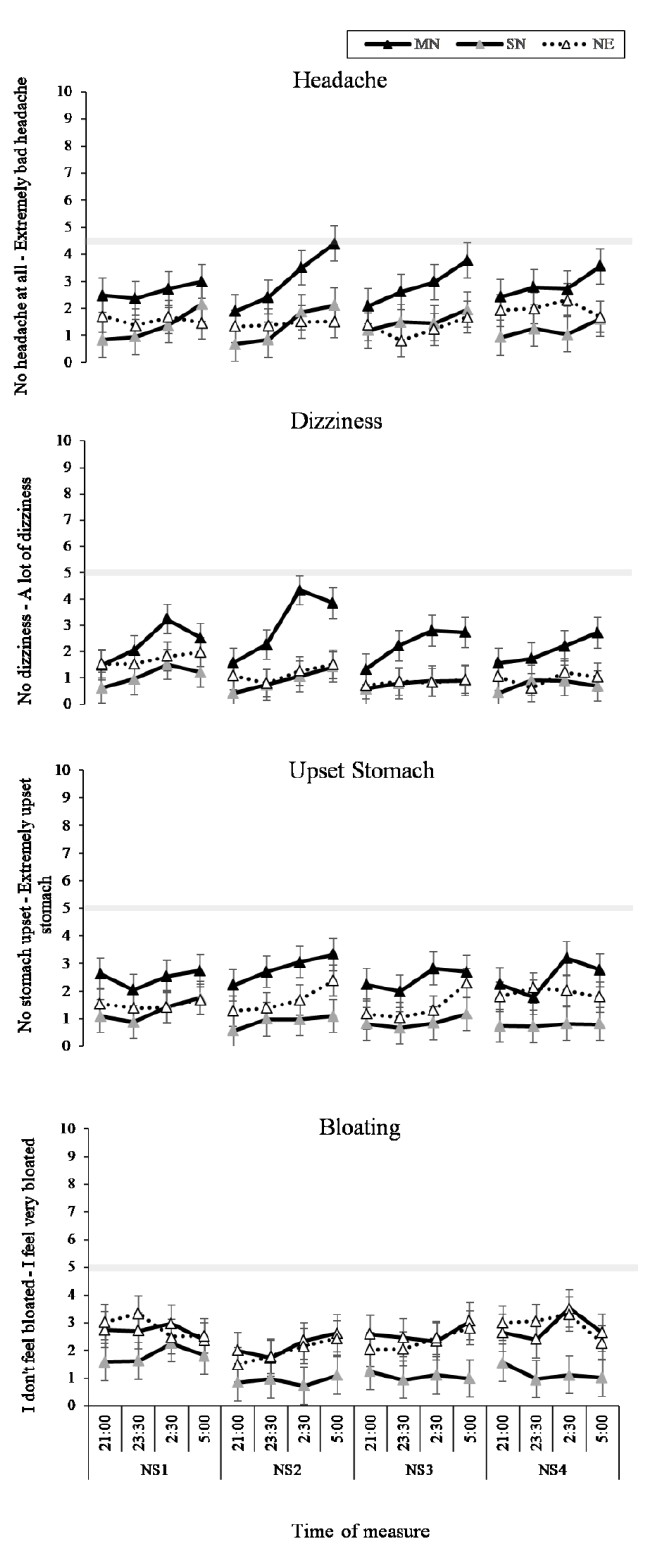
Figure 7. Headache and Gastrointestinal Symptoms (GI) VAS results from the interaction e ff ect between eating condition by time of night by nightshift (NS1-4). Black lines with black markers represent the Meal at Night condition (MN), black lines with grey markers represent the Snack at Night condition (SN), dashed lines with white markers indicate the No Eating at Night condition (NE). The grey shaded horizontal line on each line graph indicates the midpoint of each VAS. Means presented are estimated marginal means, and error bars indicate standard errors from model